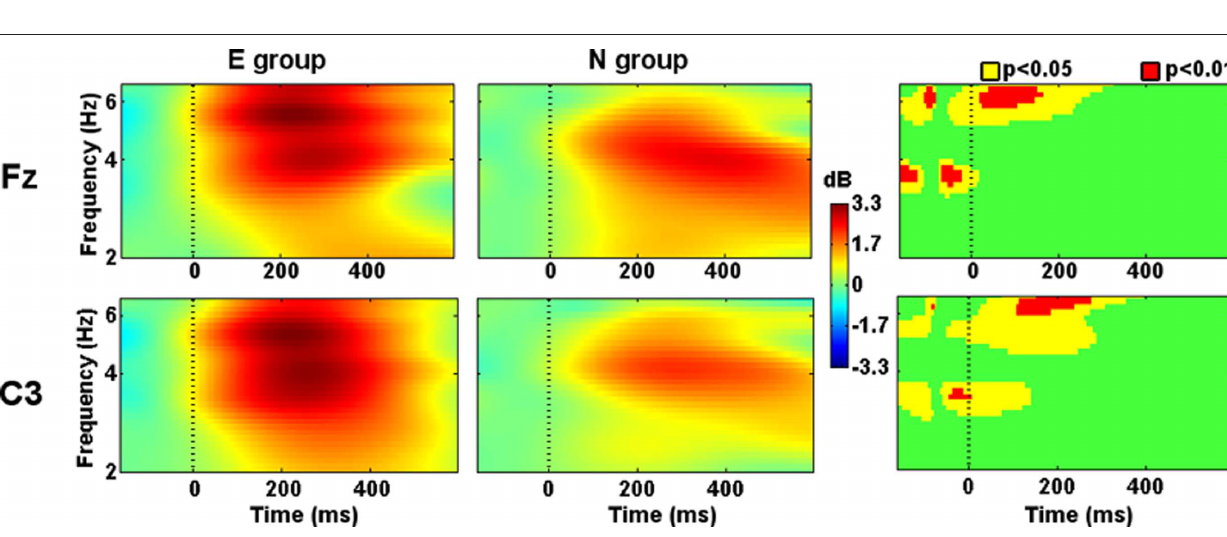
Frontiers in Behavioral Neuroscience